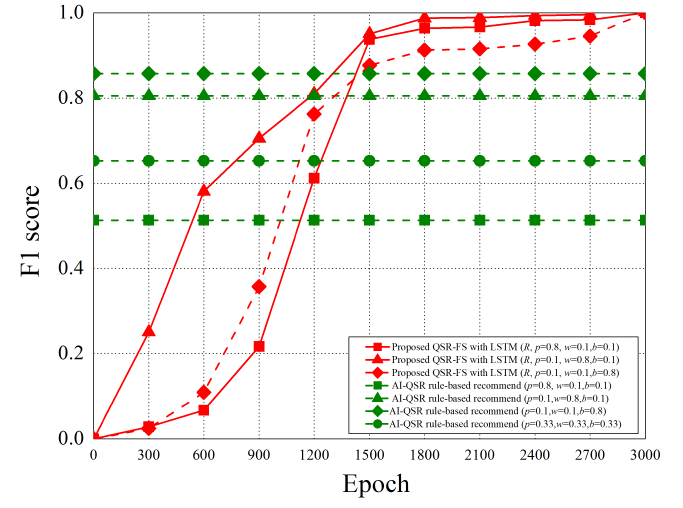
Figure 20. F1 score vs. per